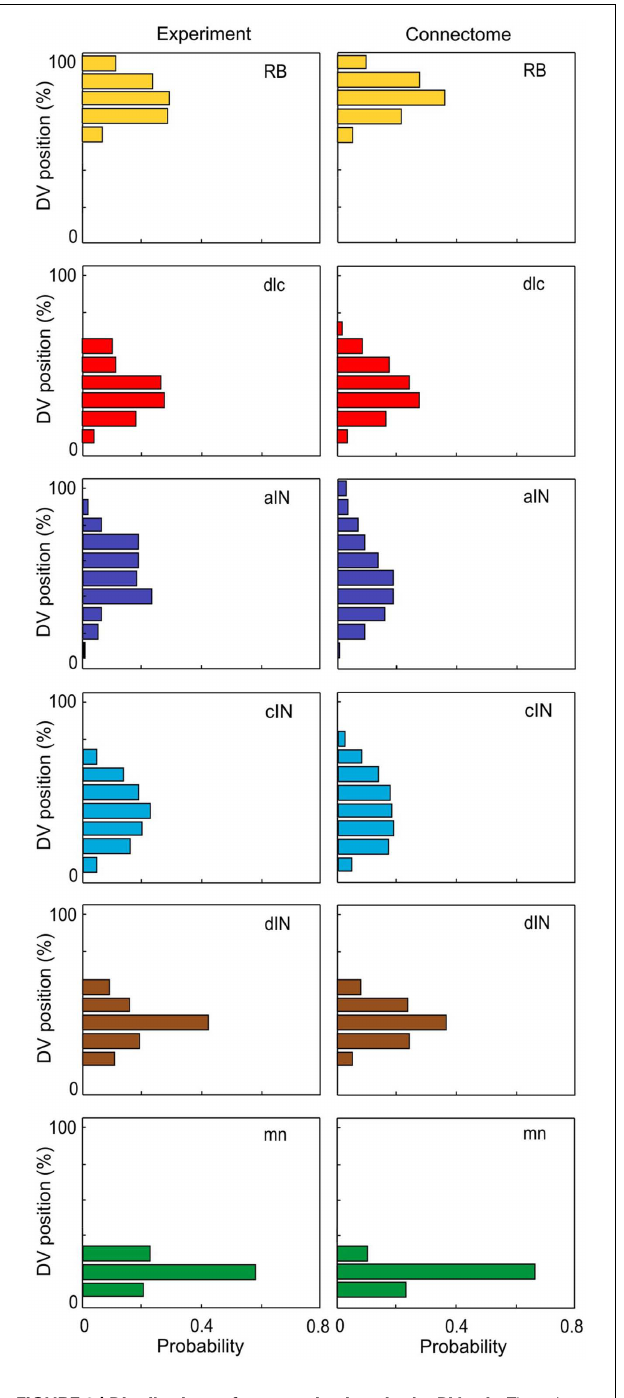
FIGURE 3 | Distributions of axon projections in the DV axis. There is a good match between distributions from experimental measurements (left, based on Li et al., 2007) and the connectome (right). In each case DV is divided into 10 bins.